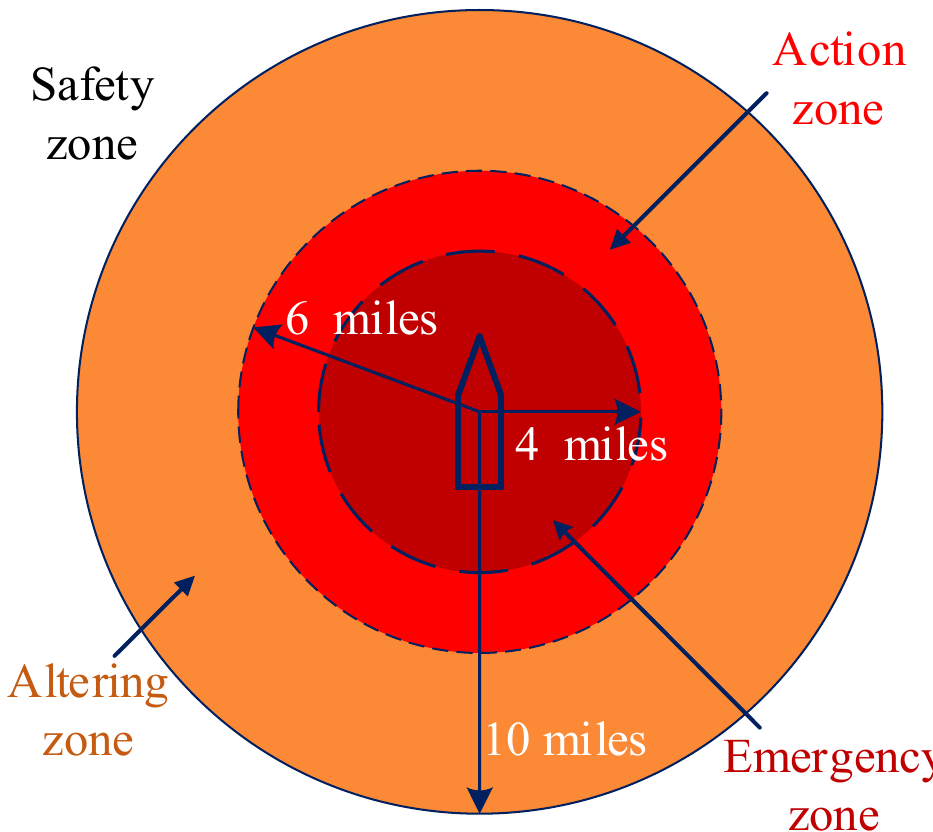
Figure 2. The subdivision of area around the